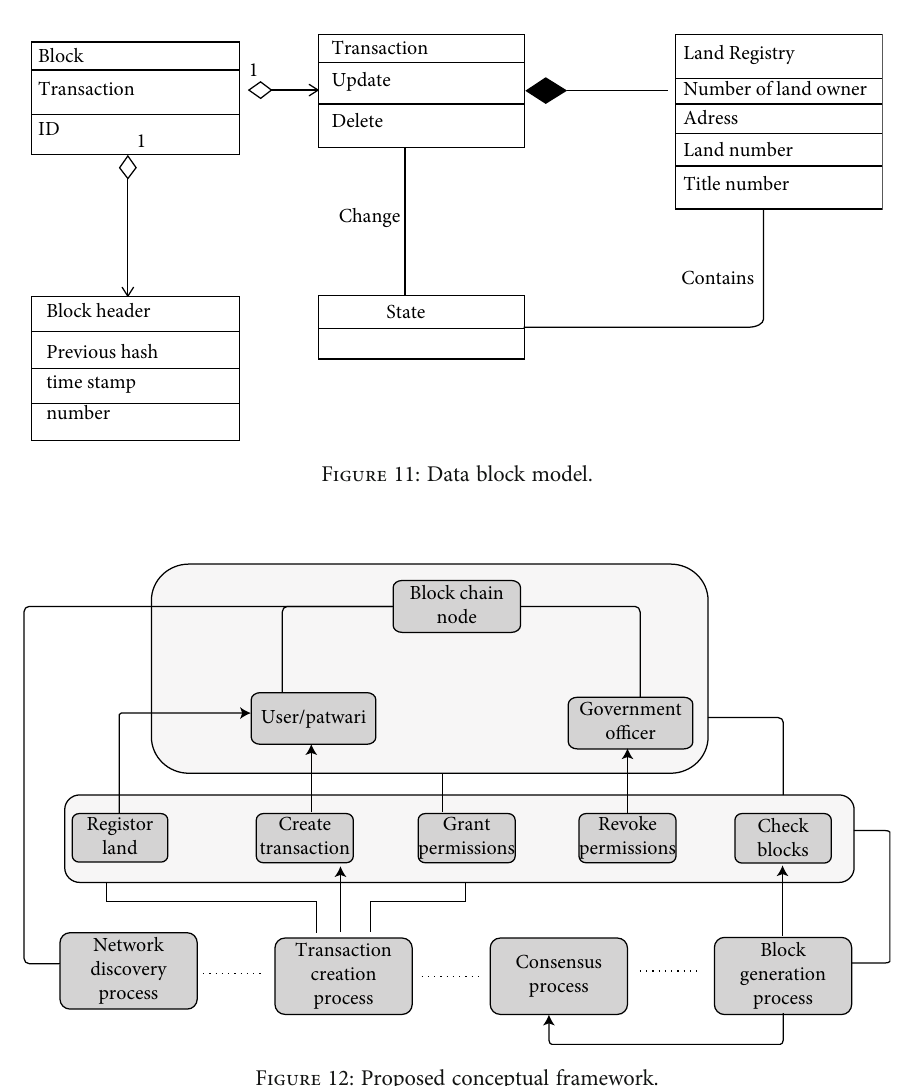
Figure 12: Proposed conceptual